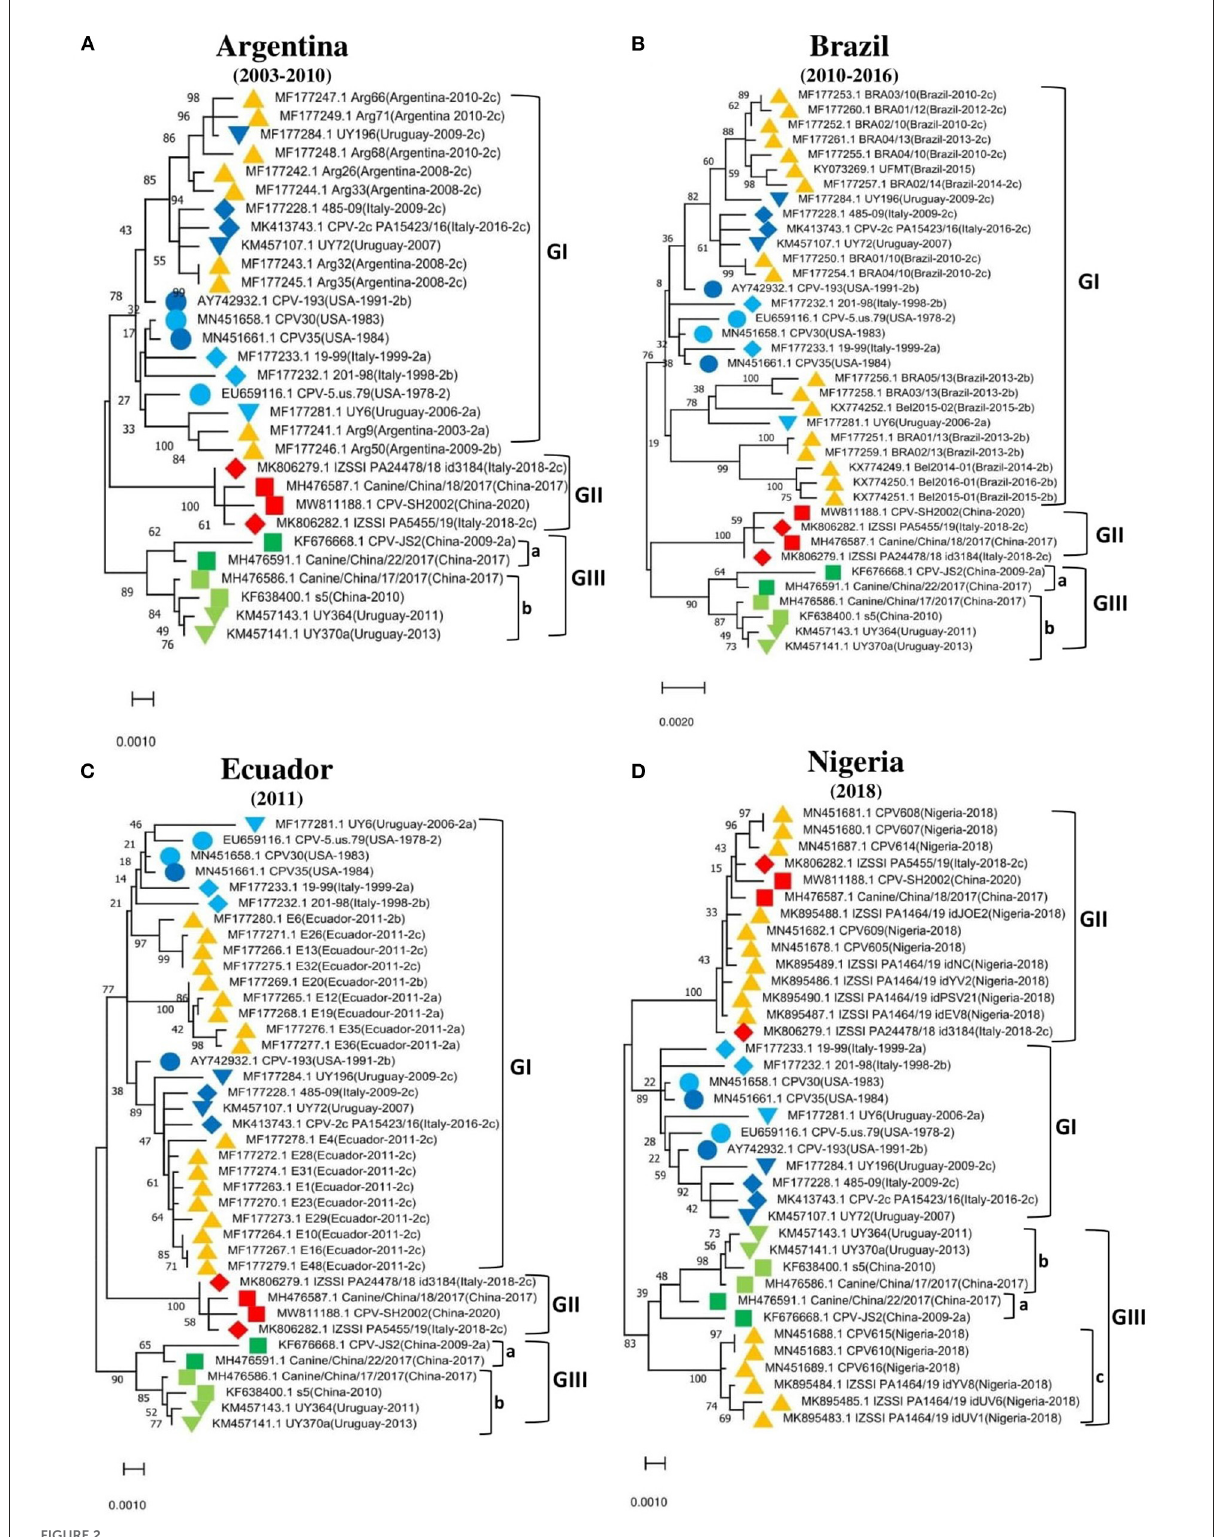
FIGURE2 Phylogenetic analysis based on the full-length genome of CPV-2 strains from different regions. (A) Argentina ( n = 9), (B) Brazil ( n = 17), (C) Ecuador ( n = 18), (D) Nigeria ( n = 10). Trees were generated using the Maximum-Likelihood approach and MEGA 11 software. The numbers at each branch indicate the percentage of bootstrap values of 1,000 replicates. The evolutionary distances were computed using the Maximum Composite Likelihood method. The scale bar reveals the number of inferred substitutions per site. The CPV-2 strains are identified in a format